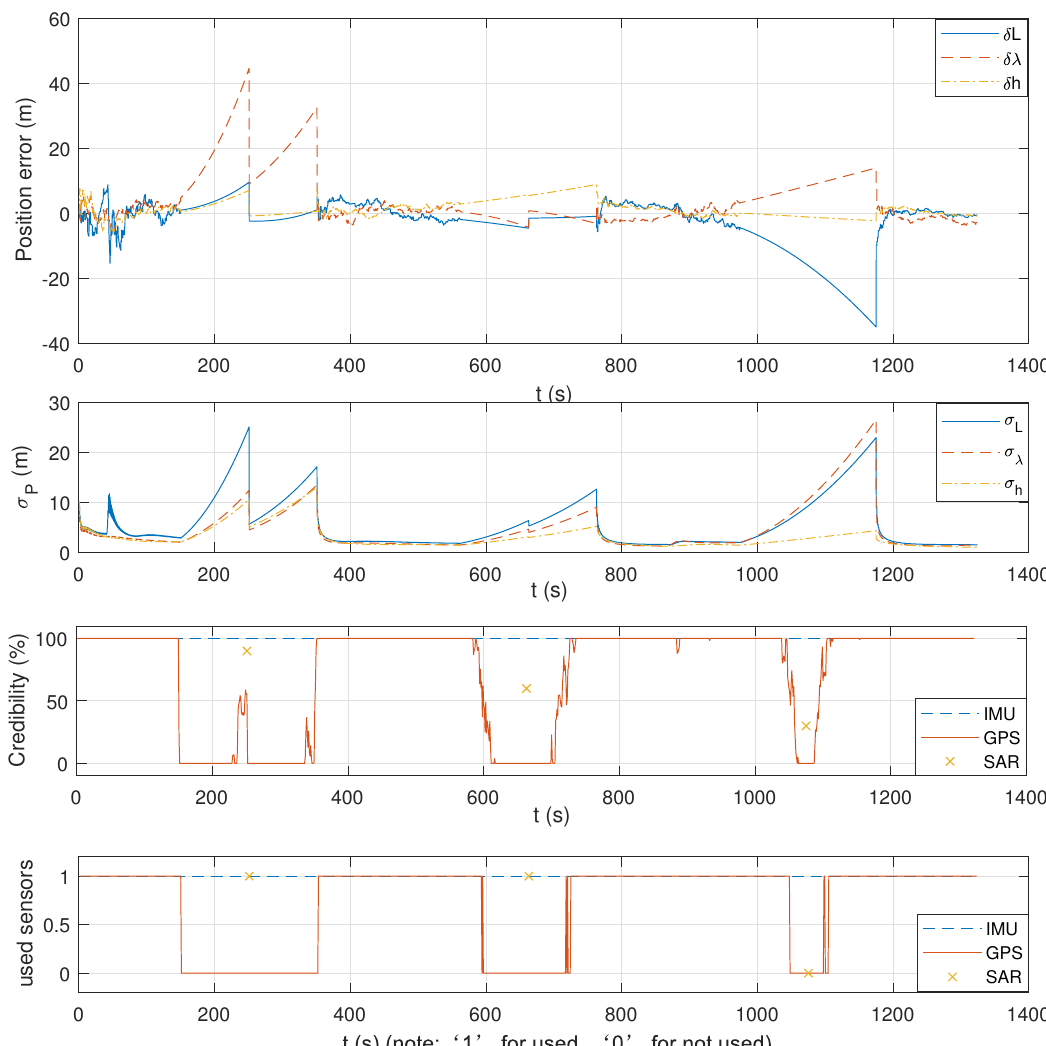
Figure 15. SINS/SAR/GPS position error and standard deviation with adjusted